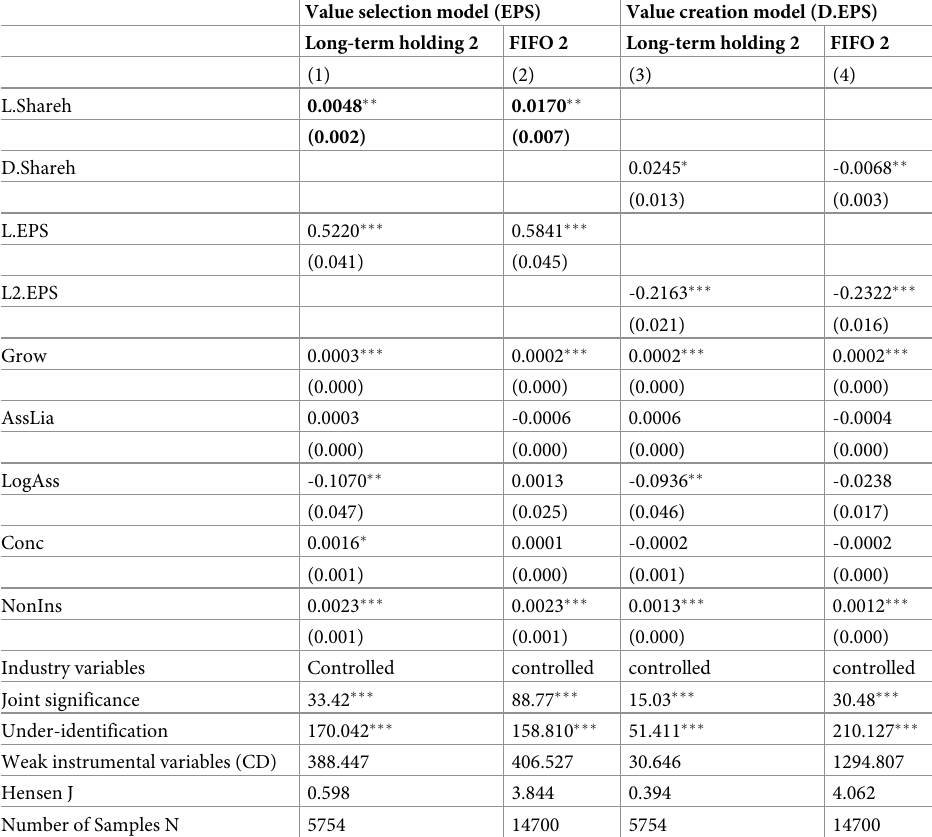
Table 8. Value selection and creation models with longer duration for long-term holding and shorter duration for